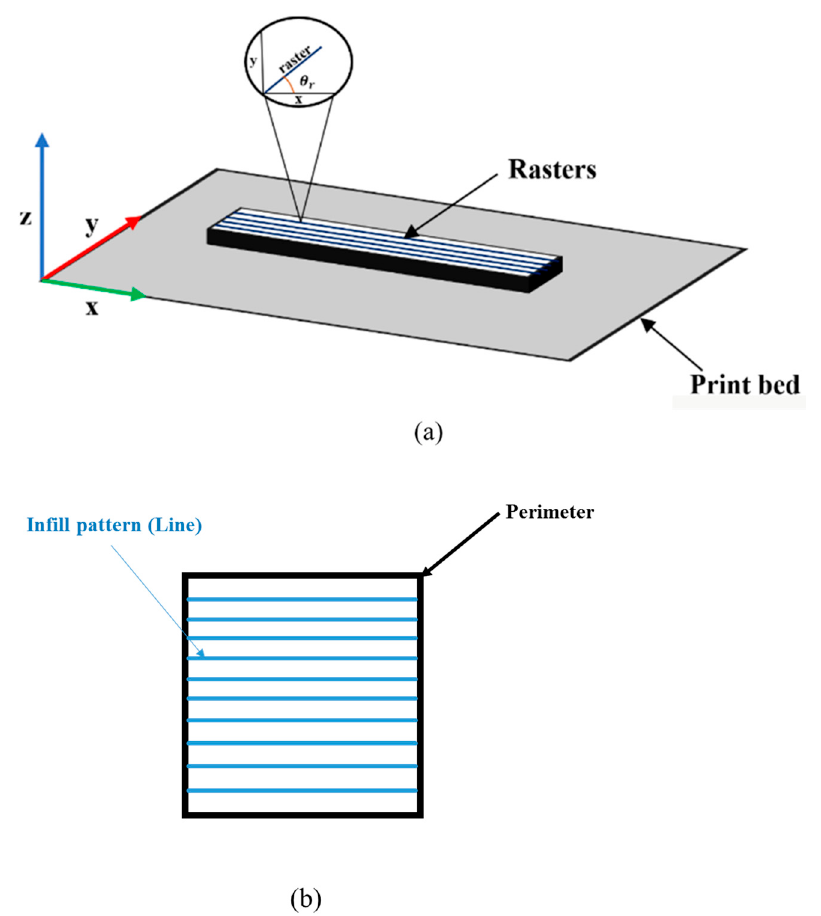
Figure 1. Schematic representations ( a ) raster angle ( b ) infill pattern (Line) and perimeter. Flexural properties are of great importance for composite and sandwich structures.